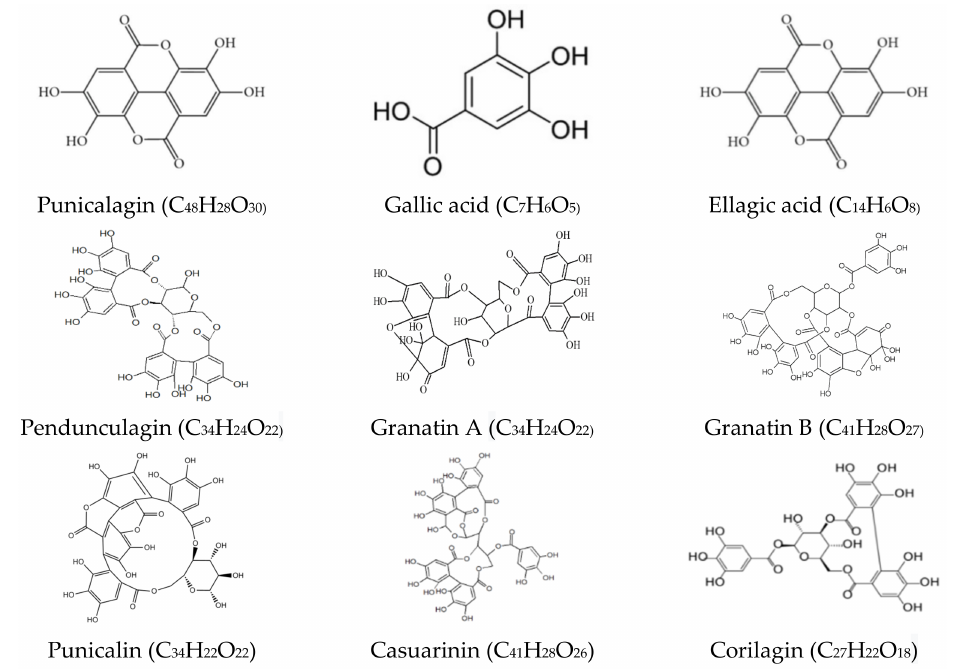
Figure 1. Chemical structure of major phenolic compounds in pomegranate peel